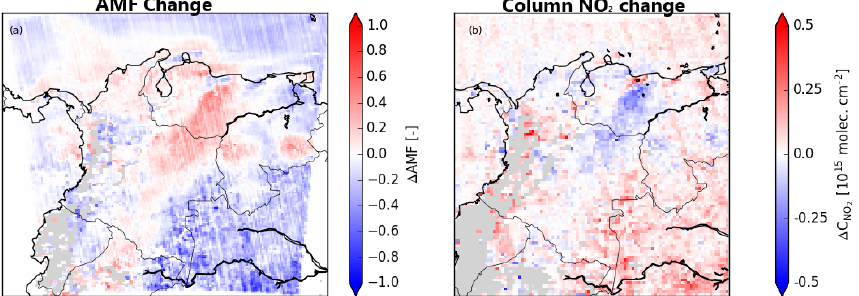
Figure 3. Spatial distribution of (a) the AMF difference (recalculated minus QA4ECV standard product; (cid:49) AMF; –) in January 2014 based on the WRF-Chem simulation and (b) the subsequent effect on the NO 2 column difference (recalculated minus QA4ECV standard product; (cid:49)C NO ; 10 15 moleculescm − 2 ) on the WRF-Chem 2